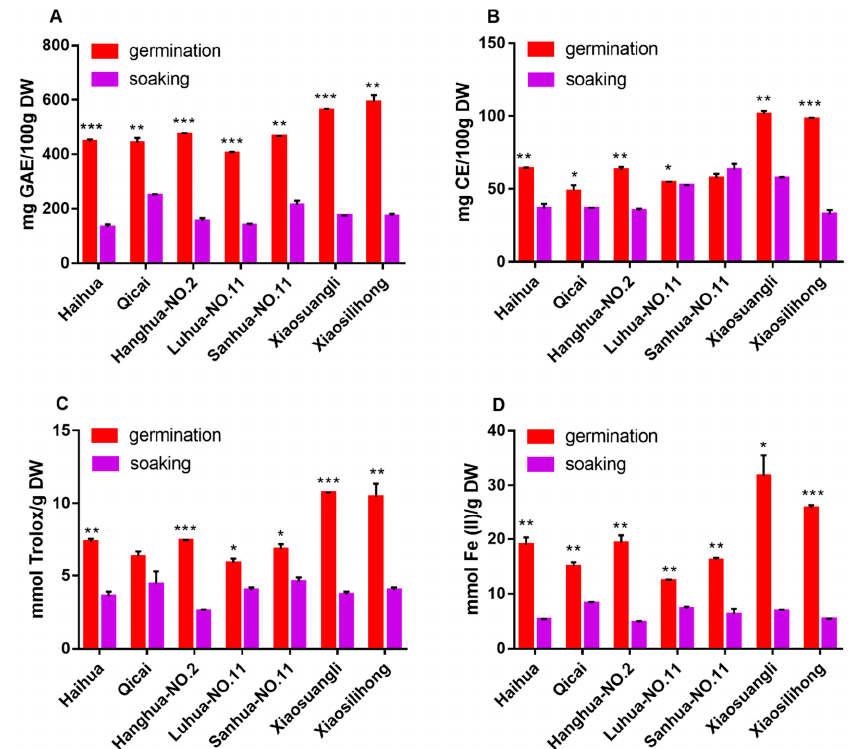
Figure 1. Evaluation of antioxidant phenolics in soaked and germinated peanut extracts. ( A ) Total phenolic content. ( B ) Total flavonoid content. ( C ) DPPH free radical scavenging activity. ( D ) Ferric-reducing antioxidant power. * p < 0.05, ** p < 0.01, *** p < 0.001. GAE: gallic acid equivalent; DW: dry weight;